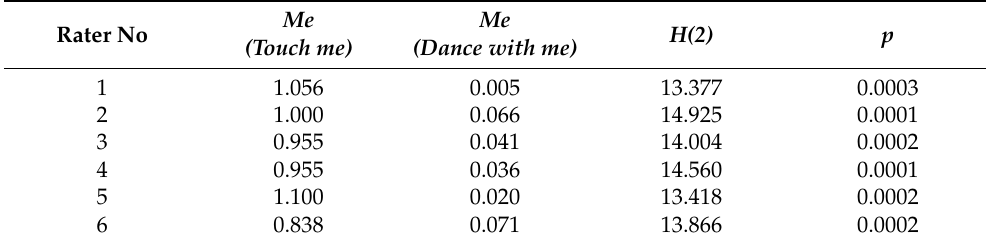
Table 1. Non-parametric (Kruskal–Wallis) test for turn-taking ratios by rater, regardless of diagnosis. Me Rater No